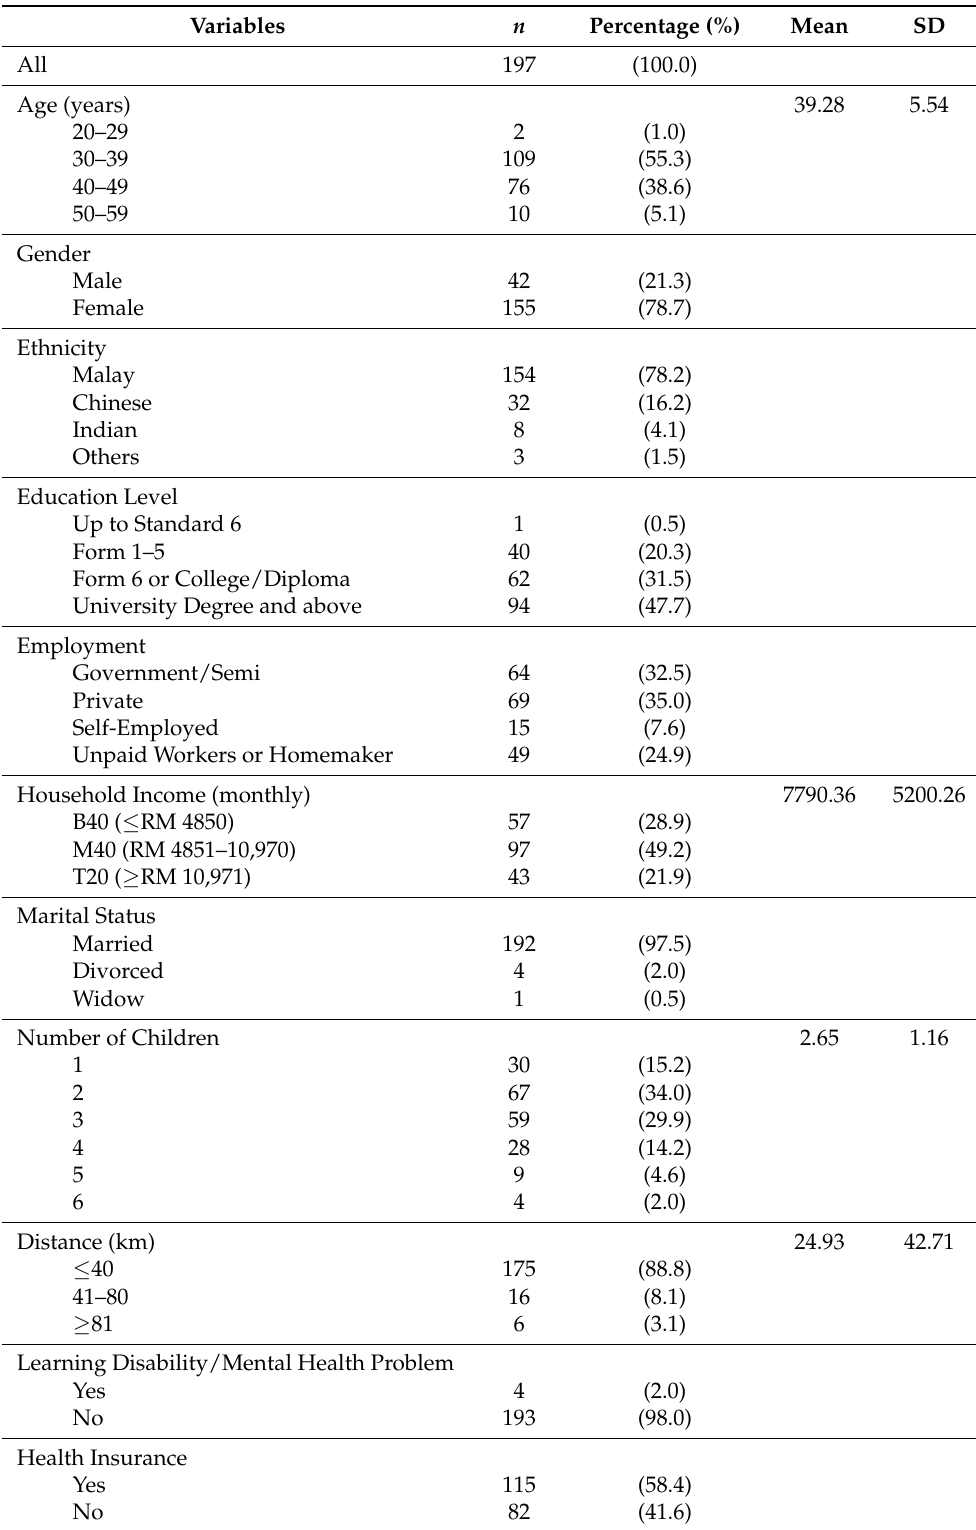
Table 2. Sociodemographic and characteristics of caregivers ( n =